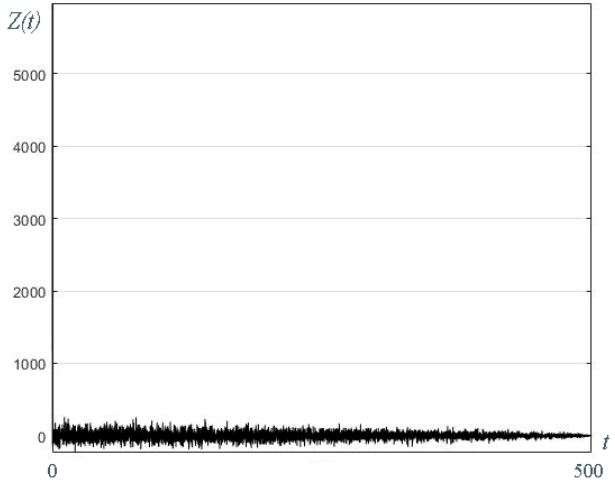
Figure 7. Correlograms of Z(t) : ( a ) idle transmission (without useful signal); and ( b ) transmission with useful signal (nonlinear, multiplicative modulation).